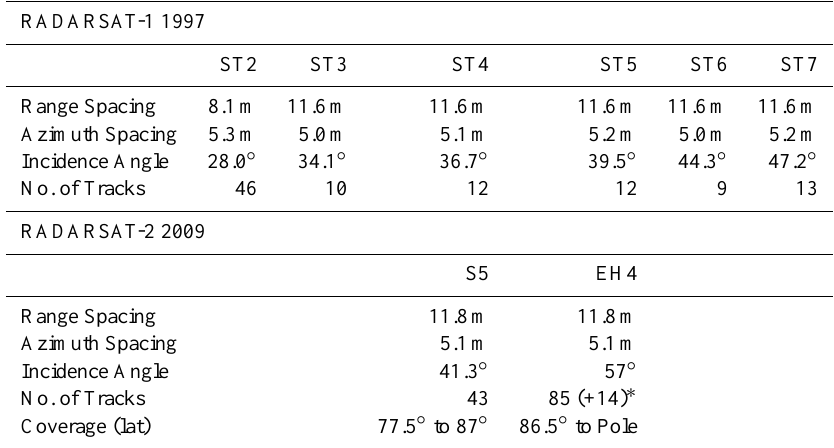
Table 1. Left-looking RADARSAT-1 (September–October 1997) and RADARSAT-2 (February–April 2009+limited gap filler in 2011) modes used for interferometric data collection in